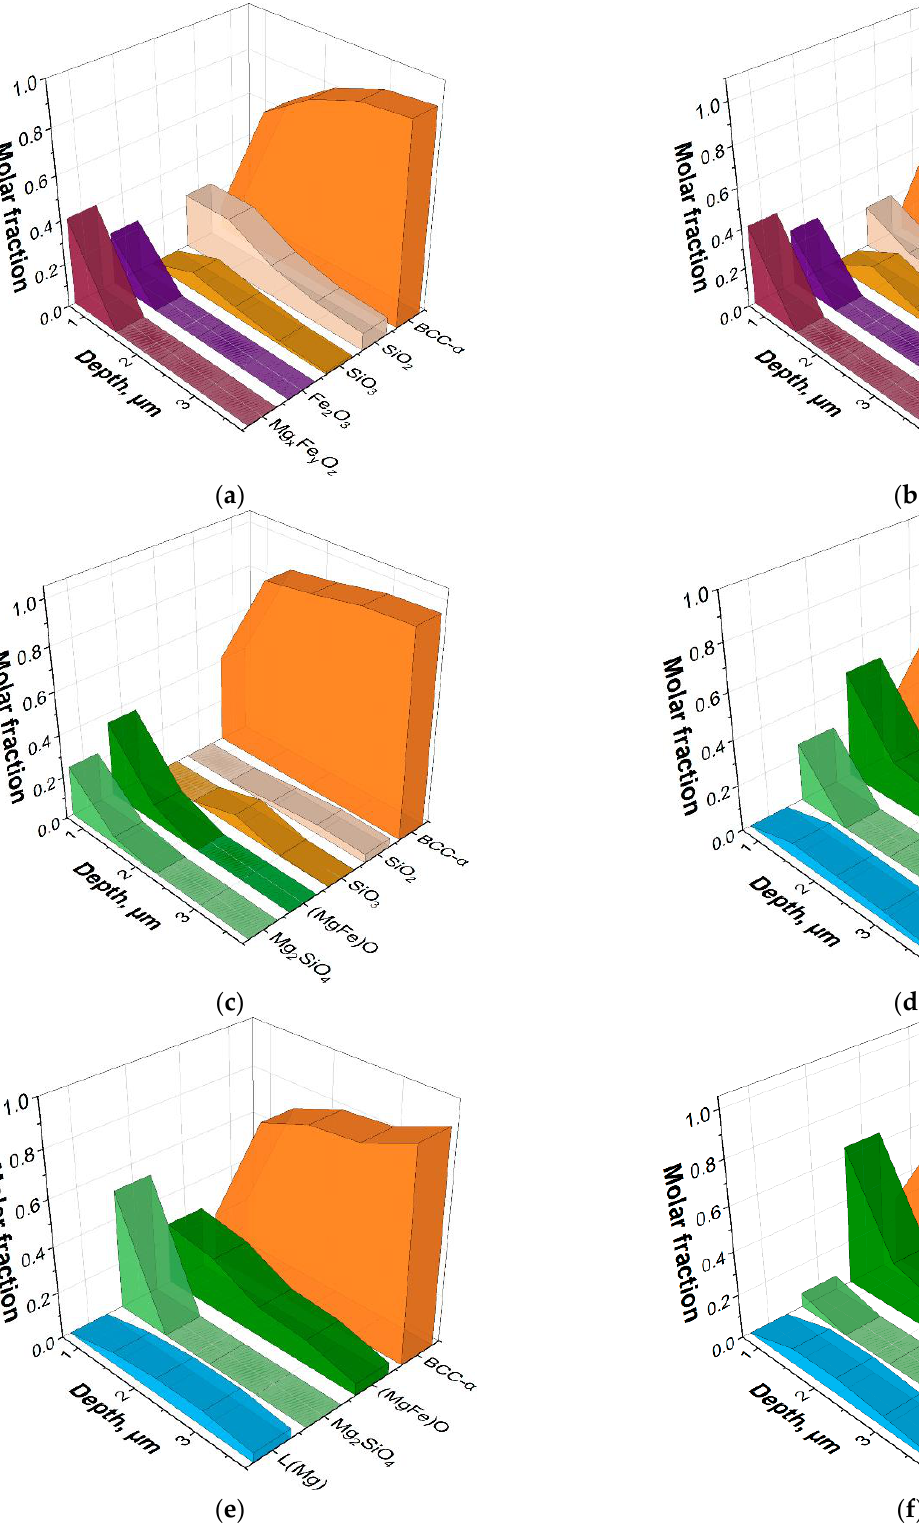
Figure 4. Results of thermodynamic calculations of possible phases in the surface layer of the Fe-3%Si-0.5%Cu alloy at temperatures: ( a ) 600 °C; ( b ) 700 °C; ( c ) 800 °C; ( d ) 900 °C; ( e ) 1000 °C; ( f ) 1100 °C.